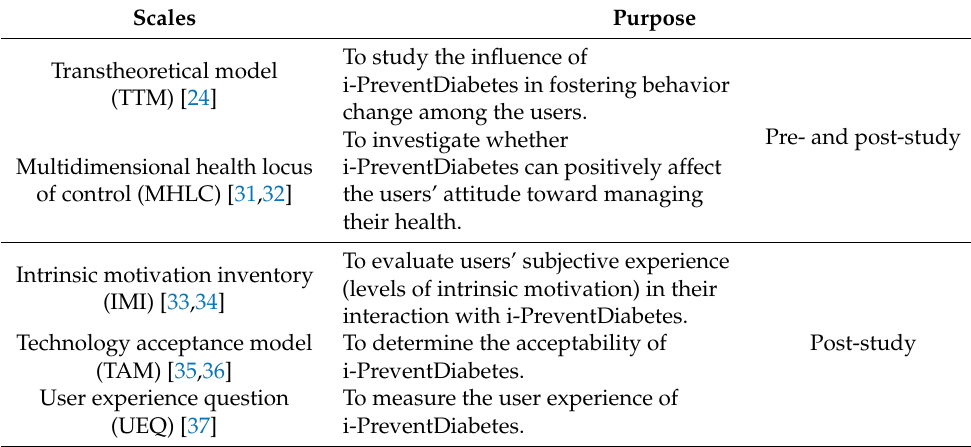
Table 5. Scales administered to evaluate